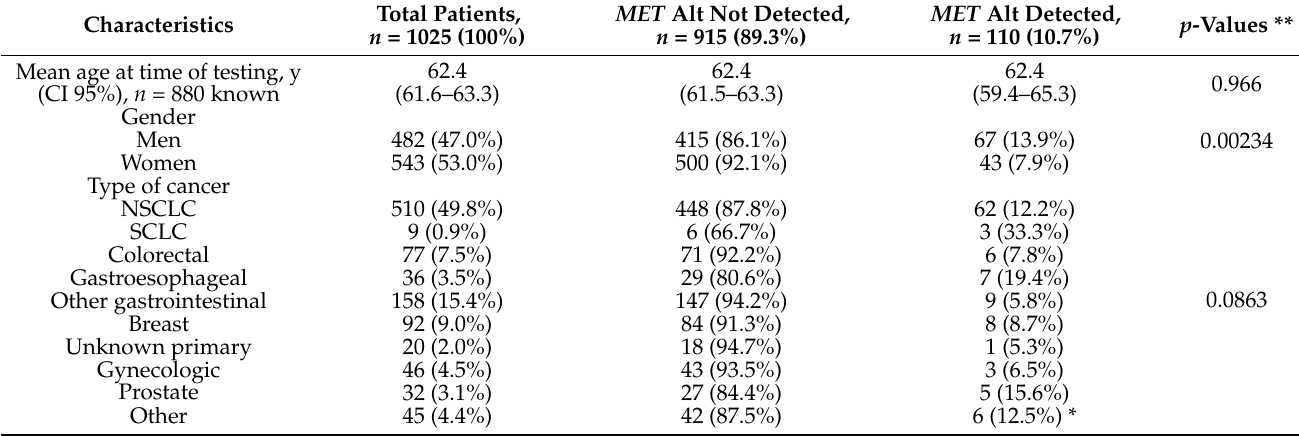
Table 1. Demographic comparison of 1025 patients with or without MET alt.